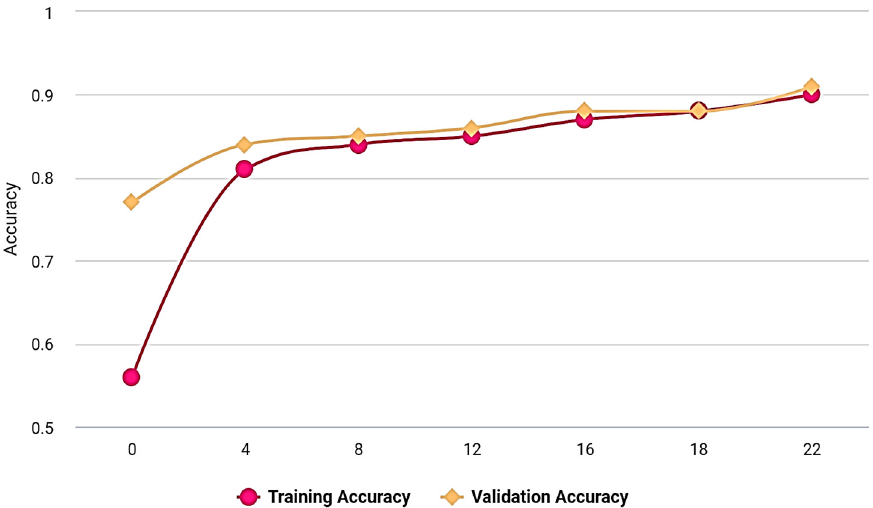
Figure 6. Training and Validation accuracy vs. Epoch. A comparison is made between the proposed model that uses EfficientNet and other classification methods commonly used in the discussed literature. Tables 5–7 represent the same against different evaluation metrics. Figure 7a–c illustrate a graphical representation of various designs across precision, sensitivity, and specificity. The recommended model is more effective due to improved dense and transition block effectiveness.